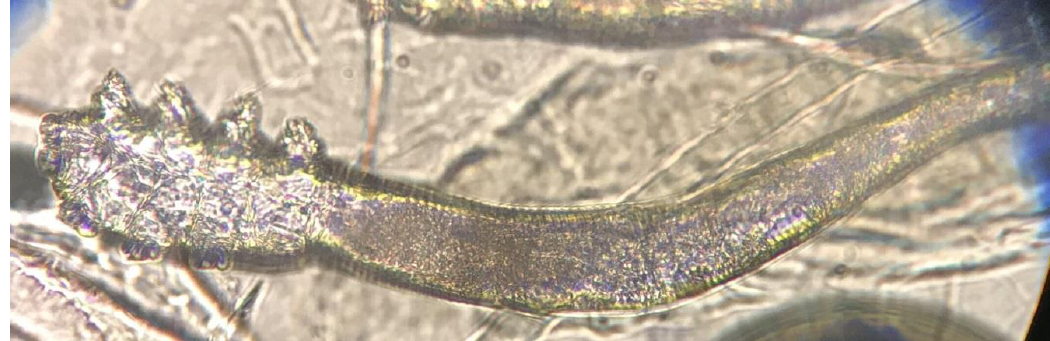
Figure 2. Demodex mite on SSSBs under x40 magnification by light microscope. Table 2. Comparison of the patient and control groups.